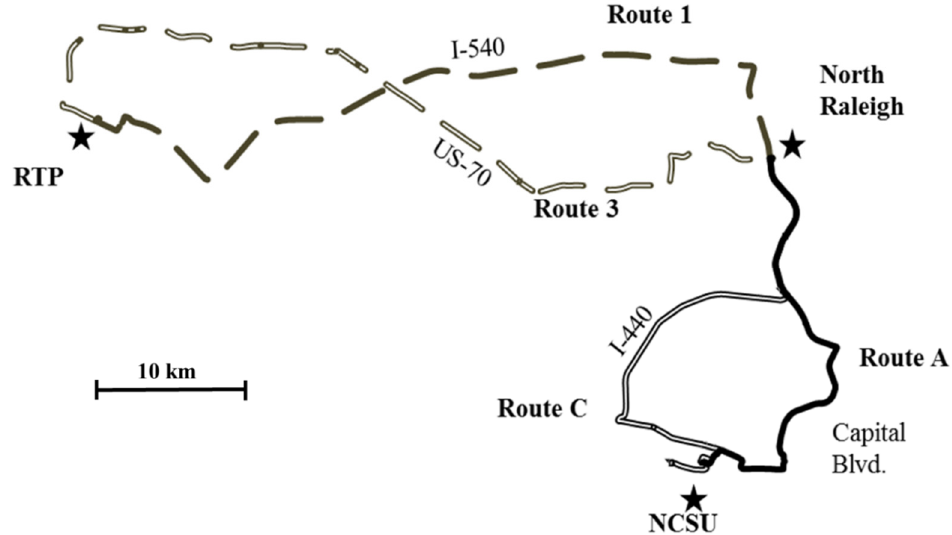
Figure 2. Four routes (Routes A, C, 1, and 3) in the Raleigh and Research Triangle Park Area in North Carolina used for hot-stabilized operation measurements. Routes A and C are between North Carolina State University (NCSU) and North Raleigh. Routes 1 and 3 are between North Raleigh and the Research Triangle Park (RTP).